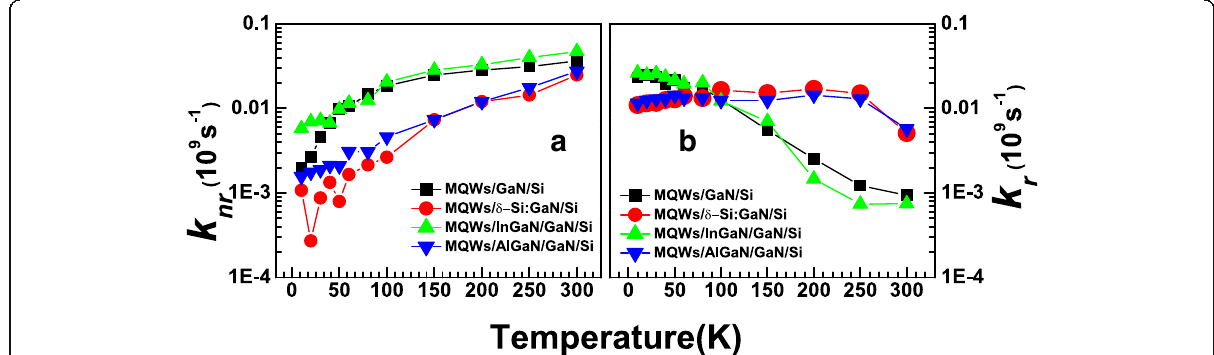
Fig. 6 a Nonradiative recombination rates vs. temperature for S1 – S4. b Radiative recombination rates vs. temperature for S1 –